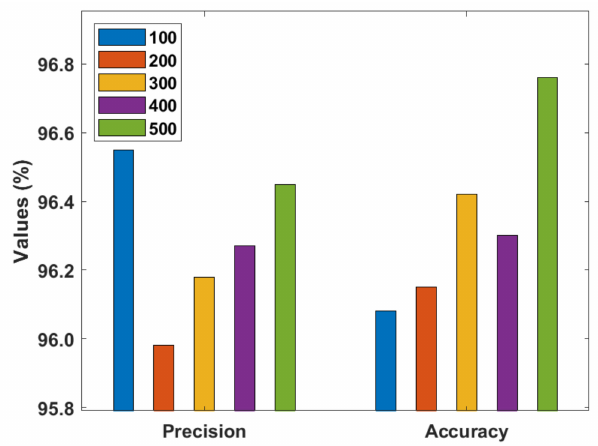
Figure 6. Precision and accuracy analysis of the DL-ICH (deep learning intracranial hemorrhage)